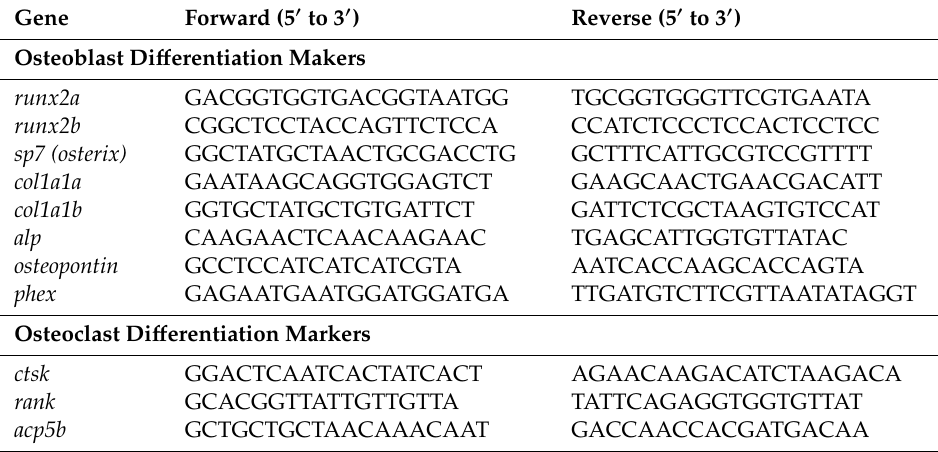
Table 1. Primer sets for Real